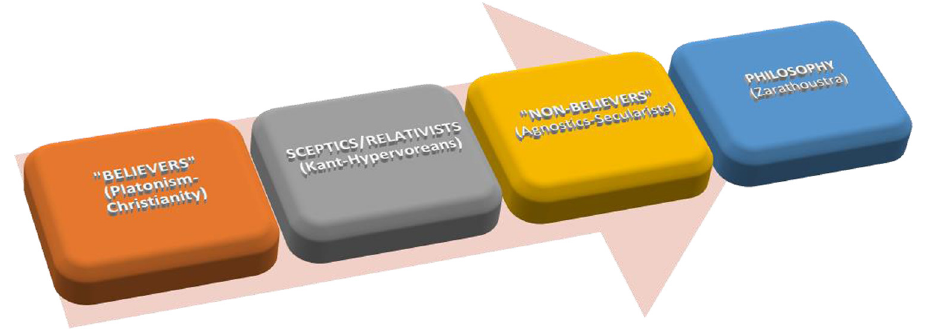
Figure 1: From the Fable world to